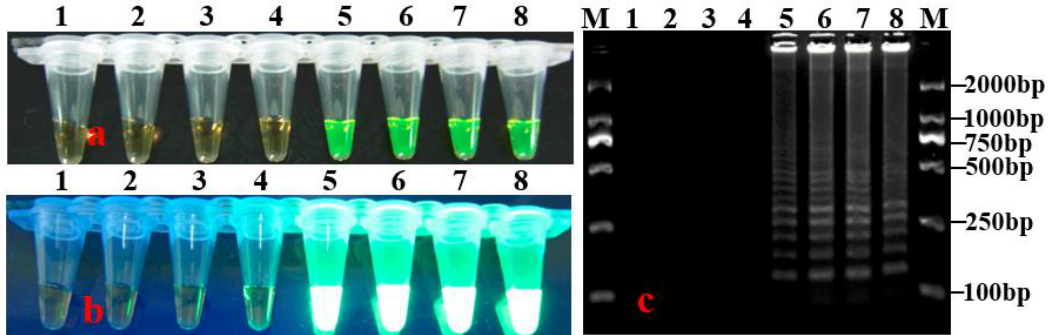
Figure 3. Optimization of LAMP reaction time for detection of M. acerina . ( a ) LAMP products were visualized by naked eye under natural light (color change, yellow-green indicate positive reaction). ( b ) LAMP products were visualized by naked eye under UV light (bright white turbidity indicates positive reaction). ( c ) LAMP products were analyzed using electrophoresis on 2% agarose gel (ladder-like pattern bands indicate positive reaction). Lane 1: negative control (SDW); Lane 2: 25 min; Lane 3: 30 min; Lane 4: 35 min; Lane 5: 40 min; Lane 6: 45 min; Lane 7: 50 min; Lane 8: 55 min; Lane M: DL 2000 DNA marker. The color of tubes 5 – 8 is yellow-green.